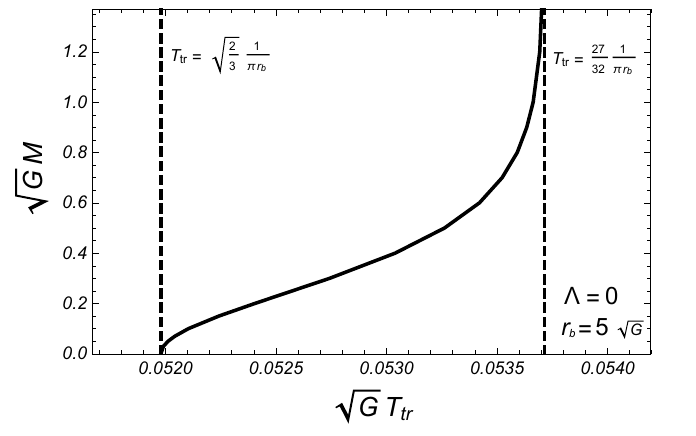
q 1 − Λ r 2 1 b 4 πG r b M